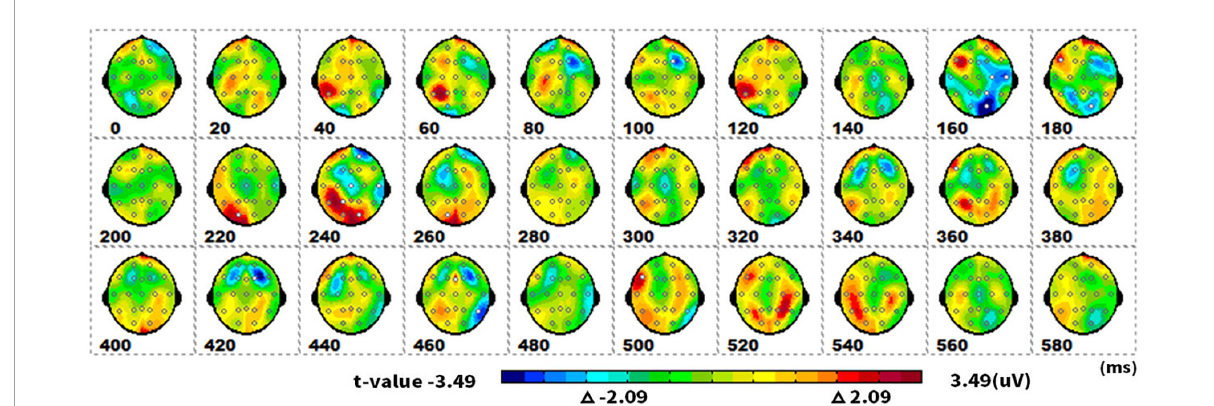
FIGURE3 The spatiotemporal patterns of SPM (t) (0 to 600 ms) are derived from the two-tailed paired t -tests (singular vs. plural). Each map was interpolated from the average t -values within the fixed 20-ms time window, and the red/bright blue bin of the color scale corresponded to the 0.05 significance threshold: t ( 1 , 19 ) = ± 2.09. The white dots represented the electrode sites with significant effects.